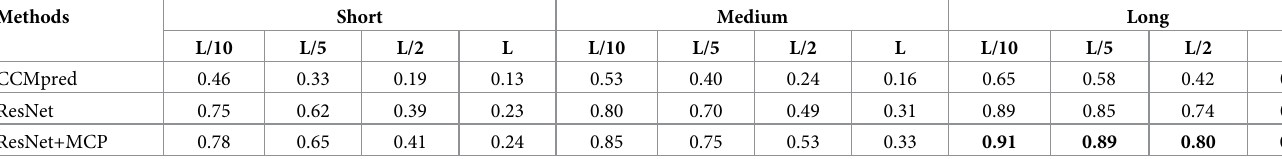
Table 2. The overall contact prediction precision of the 327 test